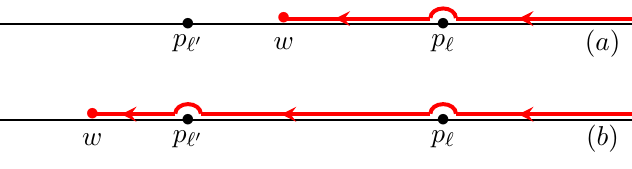
Figure 2 . Integration contour (a) when w 2 [ p ‘ 0 ; p ‘ ] and (b) when w 2 [ (cid:0)1 ; p ‘ 0